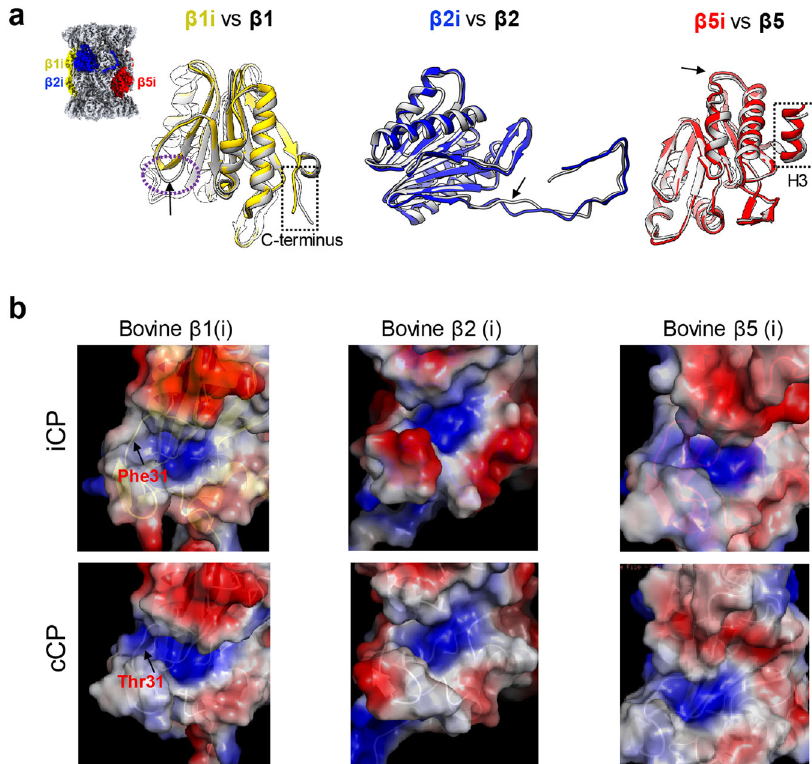
Fig. 5 Structural comparison of the bovine iCP with bovine cCP. a Structural superpositions of the three catalytic subunits of the free bovine iCP (with β 1i, β 2i, and β 5i colored yellow, blue, and red, respectively) on the corresponding subunits of the bovine cCP (in gray, PDB ID: 1IRU). The observable conformational changes are indicated by black arrow and dotted ellipsoid or rectangle, which are followed throughout. b Surface property representations of the catalytic pockets of the three enzymatic subunits for free bovine iCP and bovine cCP, with the most distinct residues between β 1i and β 1 in this region